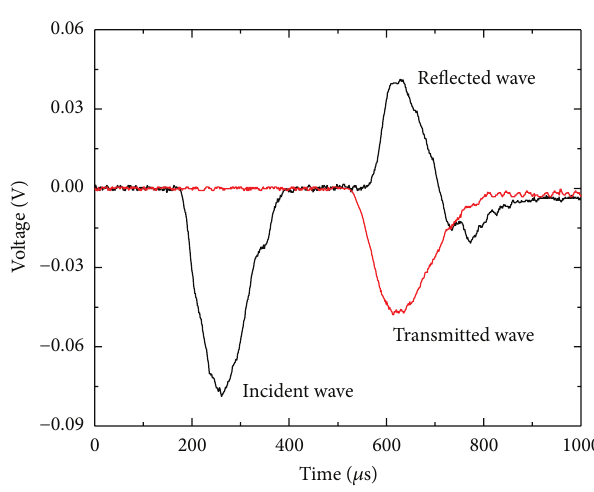
Figure 4: Electrical signals captured from strain gauges on the SHPB bars under impact